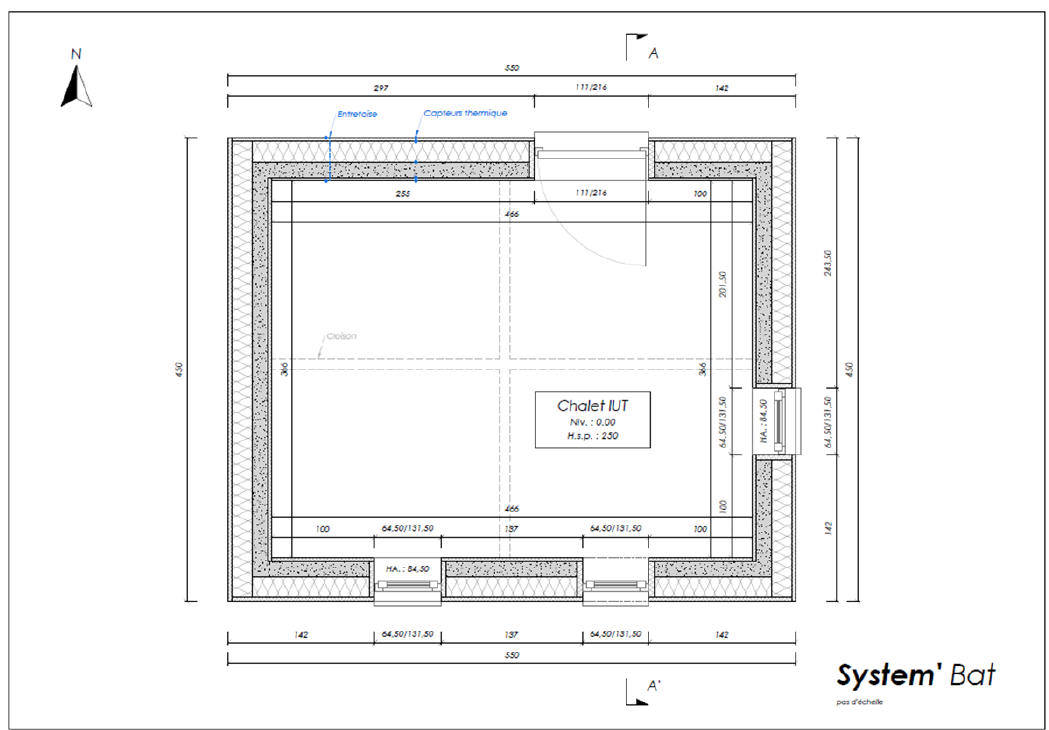
Figure A2. Horizontal cut plan of the mono-zone building.